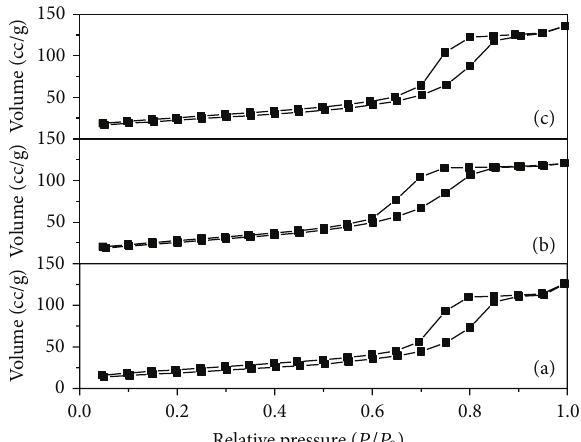
Figure 8: N 2 adsorption/desorption isotherms of synthesized TiO 2 nanoparticles: (a) 0% AC, (b) 5% AC, and (c) 10%